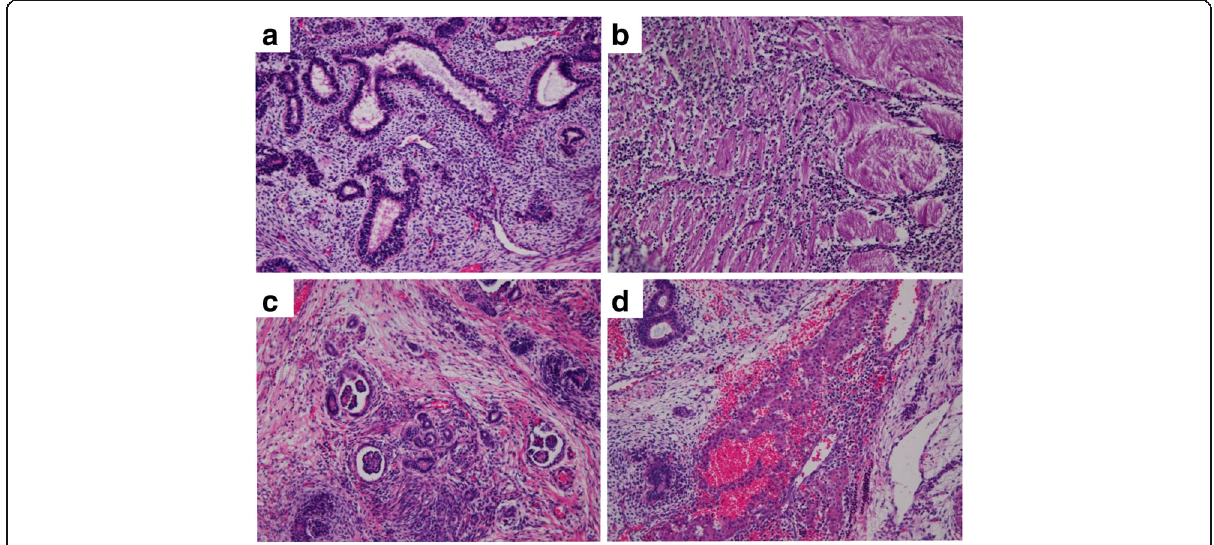
Fig. 4 Microscopic images of tridermal components in the epignathus. a Immature neural tubules (hematoxylin and eosin [HE] stain, × 100). b Smooth muscle (HE stain, × 100). c Renal glomeruli (HE stain, × 100). d Hepatocytes (HE stain, × 100)